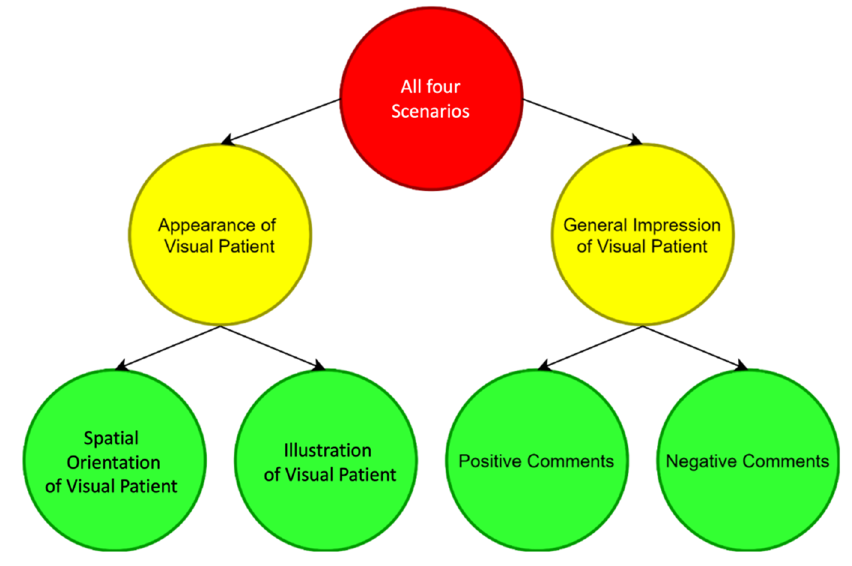
Figure 2. The coding template generated using deductive coding and free inductive coding based on recurring answers in the structured interview transcripts.